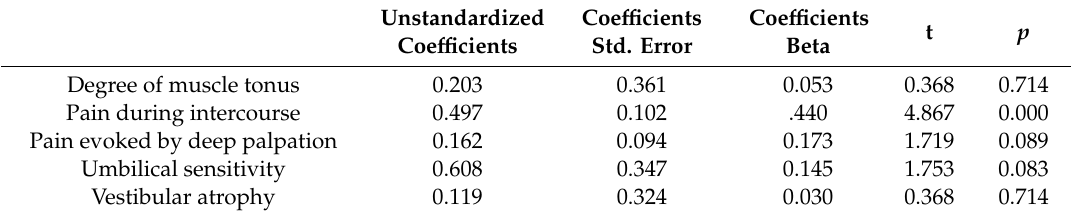
Table 4. Regression model to define predictors for pain variability in the posterior vestibule. Unstandardized Coe ffi Coe ffi cients